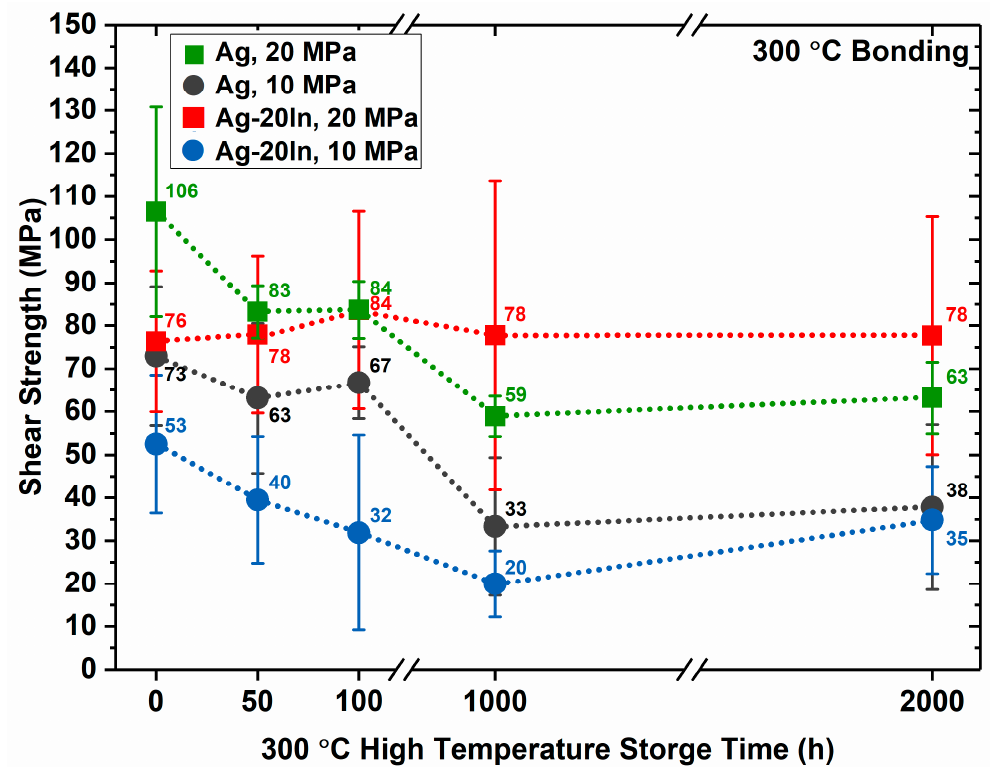
Figure 12. Variation of the shear strength for sintered Ag and Ag–In alloy joints with the thermal aging time at 300 ◦ aging time at 300 °C.